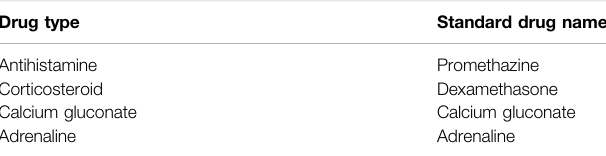
TABLE 1 | Anti-allergic marker